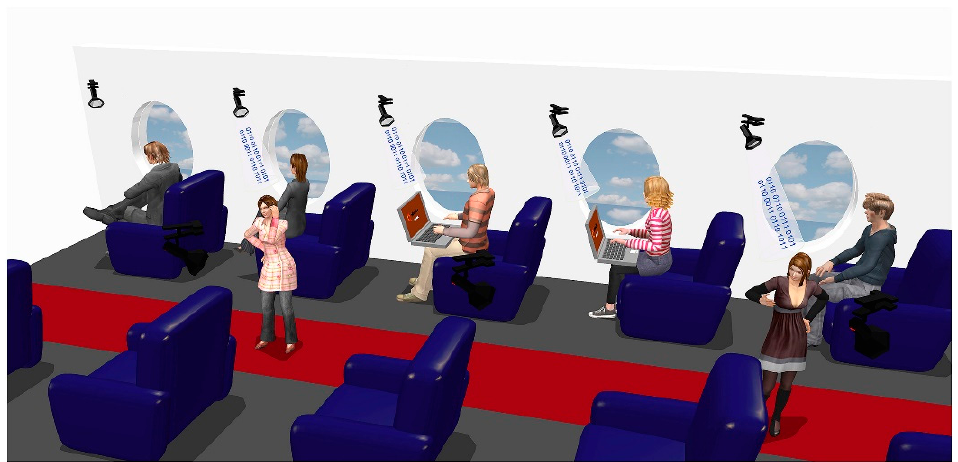
Figure 15. LiFi application in an airplane cabin. Reprinted from [28], Copyright 2019, with permission from Elsevier.